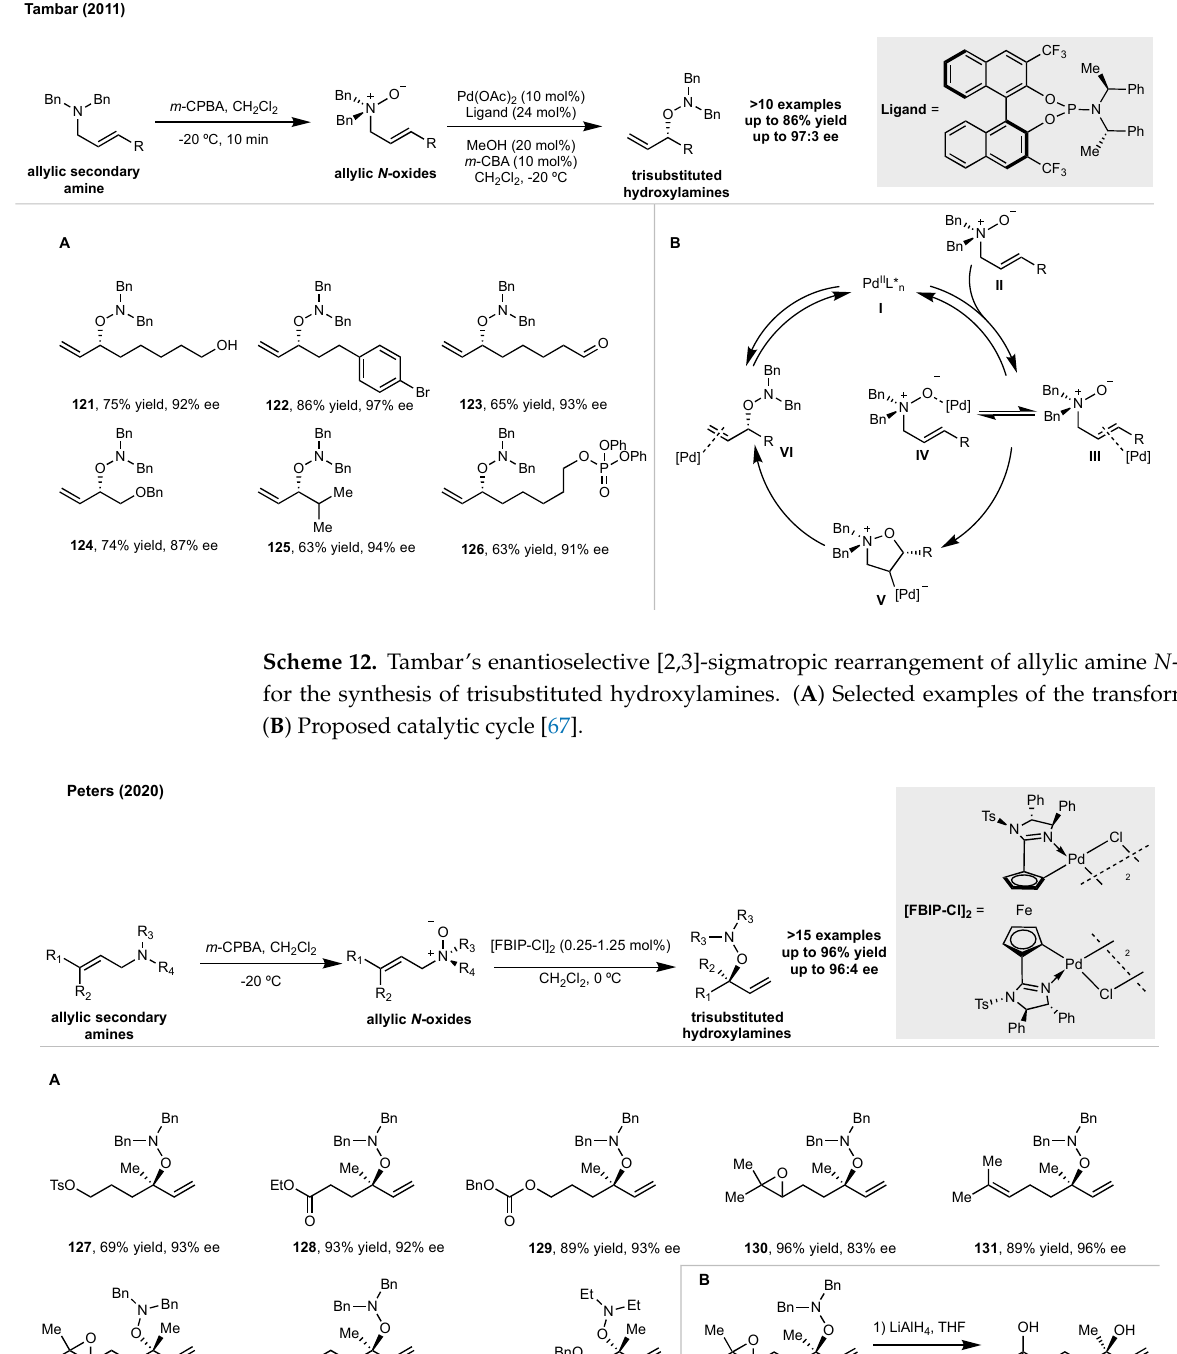
>15 examples up to 96% yield up to 96:4 ee